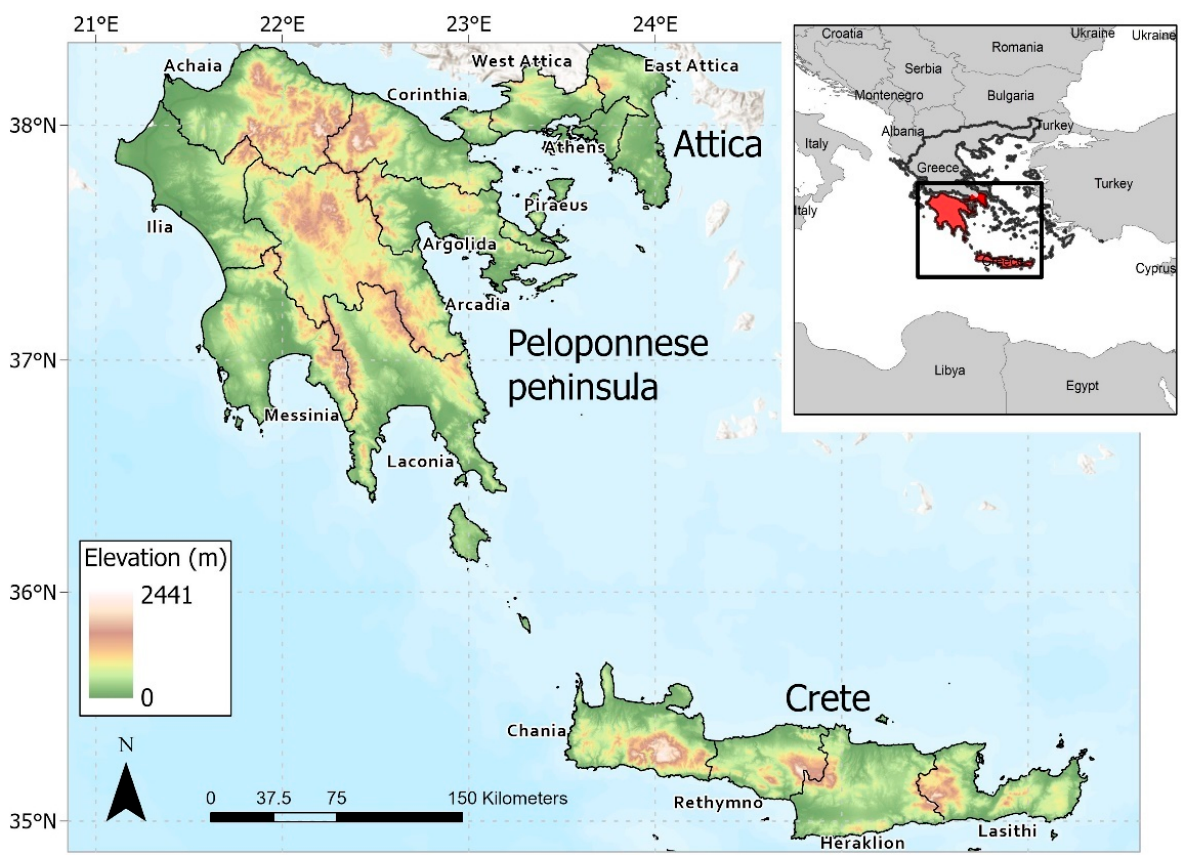
Figure 1. Study area map showing the distribution of higher elevation mountainous areas and lower elevation valleys and coastal areas. Greece prefecture boundaries are overlaid.